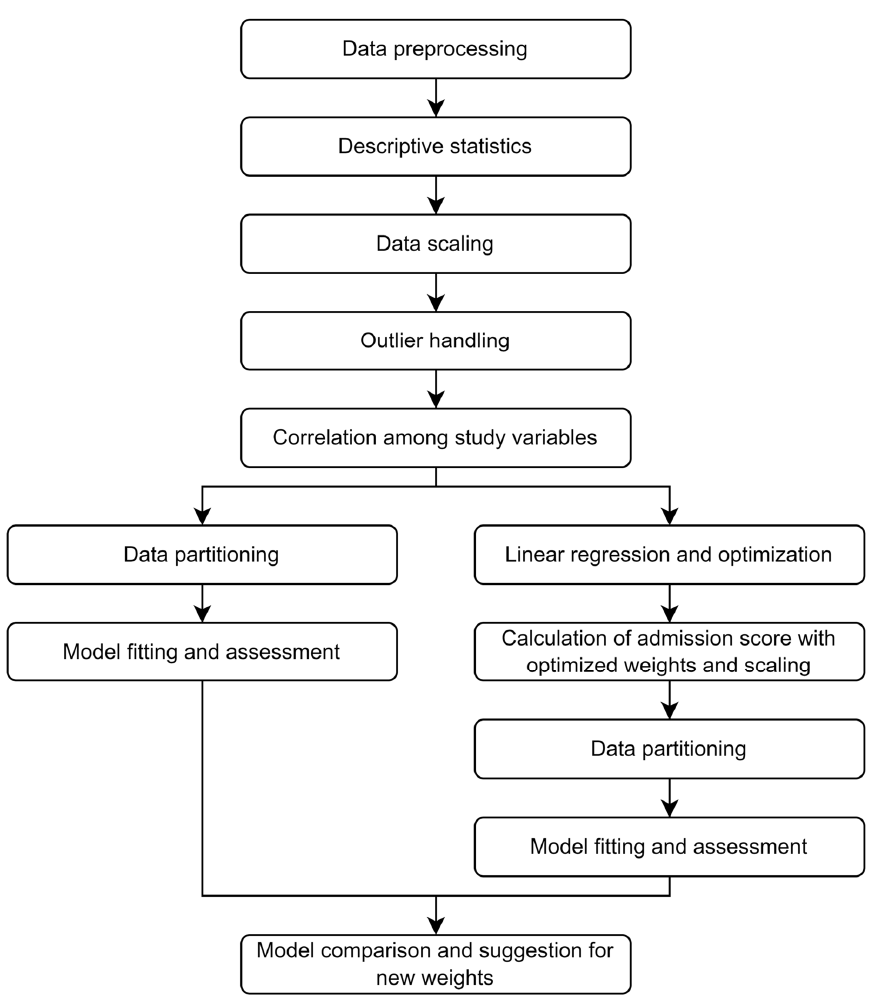
Figure 1. Research